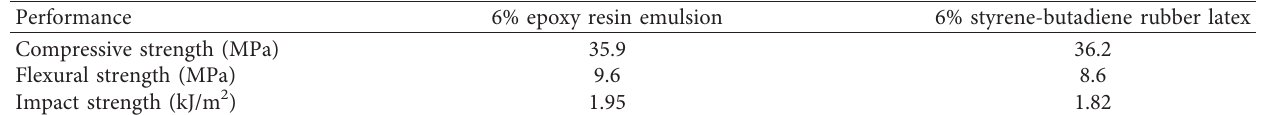
Figure 5: Impact strength of resin modified cement slurry. Table 3: Mechanical properties of different cement pastes at 7-day cure.